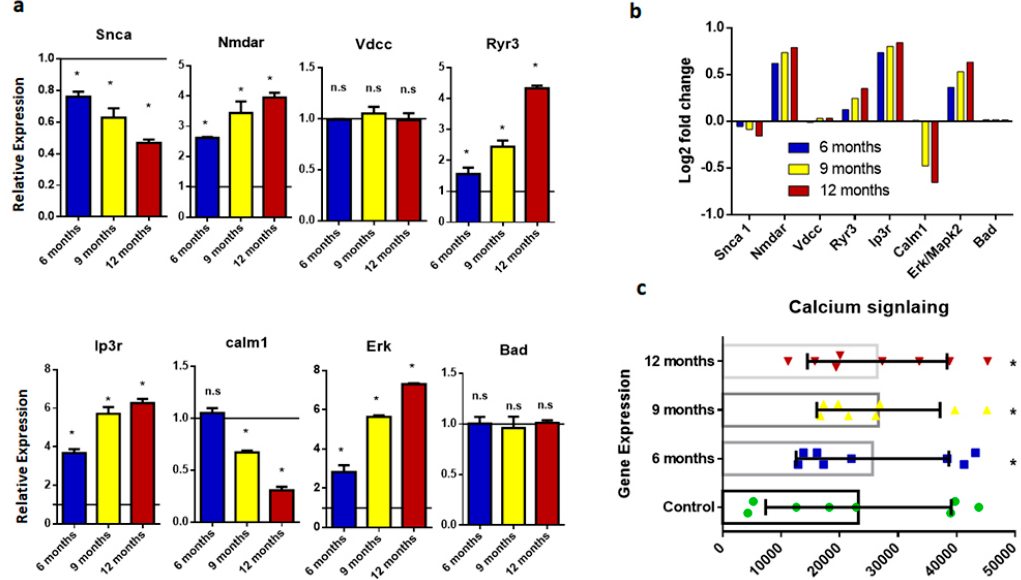
Figure 4. Expression analysis of genes involved in calcium signaling. ( a ) Histograms representing relative mRNA expression of Snca , Ip3r , Nmdar , calm1 , Vdcc , Erk , Ryr3 , and Bad . Represented values are the mean and SD obtained from three individual experiments performed for each sample. The line on the x-axis at 1.0 represents the gene expression of control samples. ( b ) Bar plots representing fold-change values represented in the log2 scale showing comparative gene expression in the brain of six-, nine-, and 12-month-old samples. Baseline shows expression in the control sample. ( c ) Scattered-dot plot showing expression of genes involved in calcium signaling. * Expression is significantly different from WT ( p ≤ 0.05). n.s., Nonsignificant.